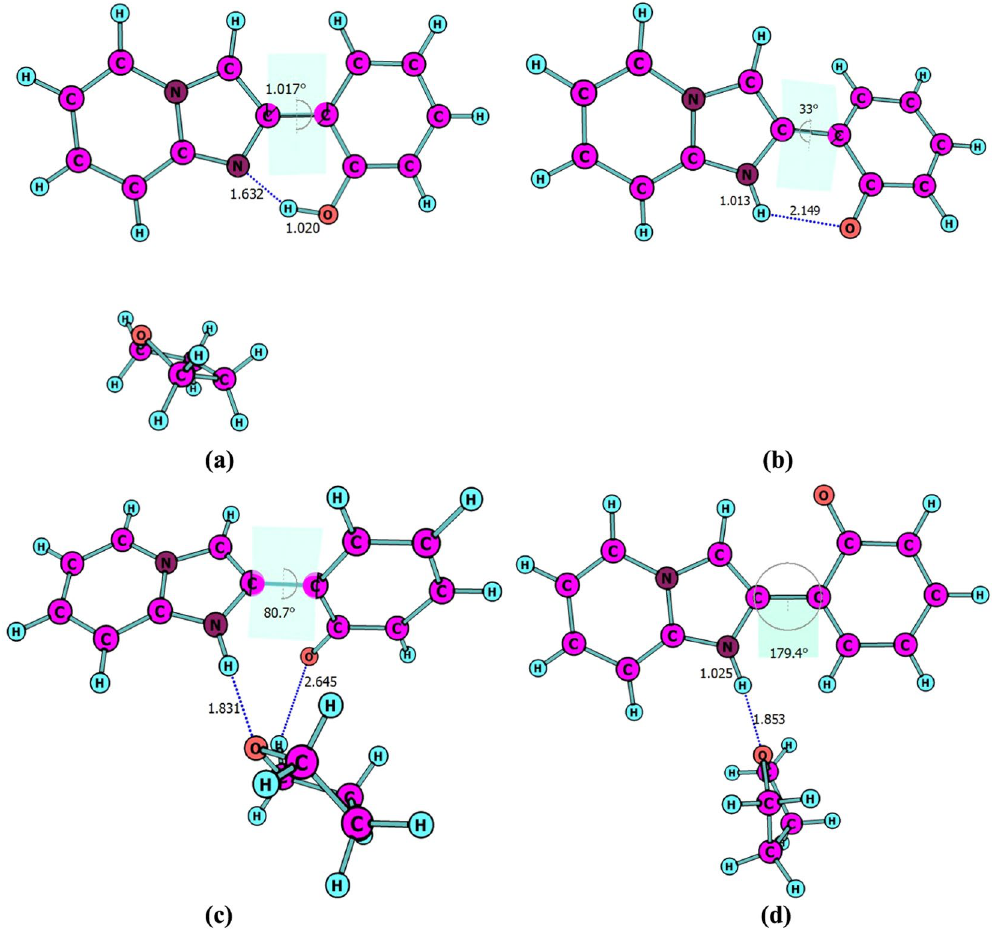
Figure 3. The optimized structures of ( a ) cis-HPIP, ( b ) ik-HPIP, ( c ) v-HPIP, ( d ) trans-k-HPIP in the S 1 state. Some crucial bond parameters have been shown.